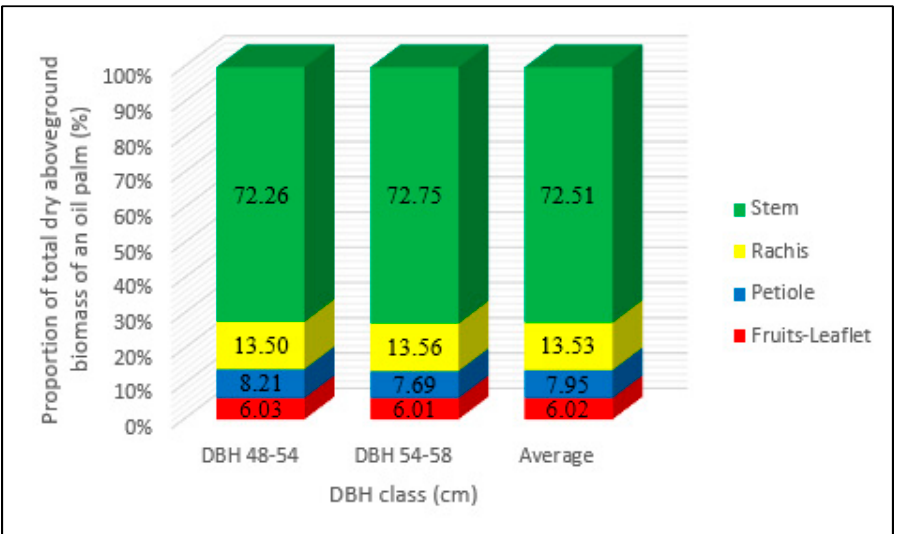
Figure 2. Mean proportions of the aboveground biomass for the 18 oil palms, Makouké, central Gabon.